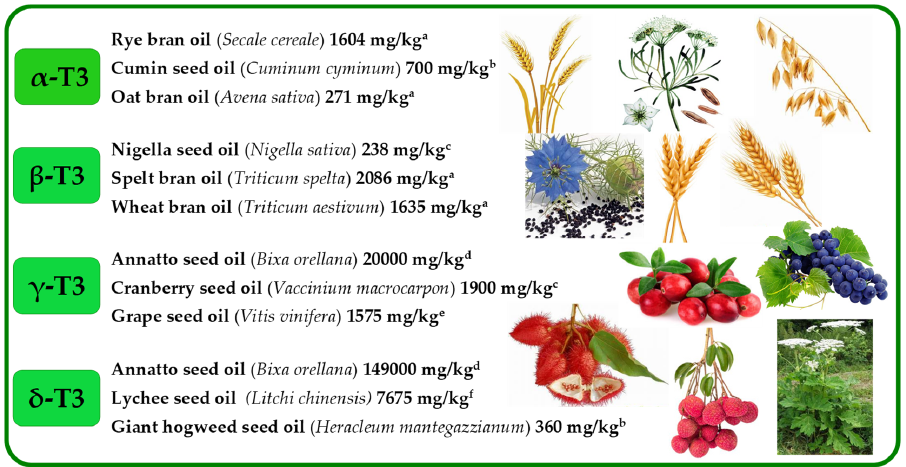
Figure 5. Selected richest sources of four tocotrienol (T3) homologues (α, β, γ, and δ). Superscripts ( a–f ) refers to the following literature positions: a , [38]; b , [50]; c , [12]; d , [54]; e , [57]; f , [63]. PC-8 was first identified by Whittle et al. [64] in the leaves of Hevea brassiliensis . PC-8 is also named -toco-octaenol and is similar to -T3, except -T3 has three unsaturated iso- prene units in the side-chain, while PC-8 has eight unsaturated isoprene units (Figure 6).